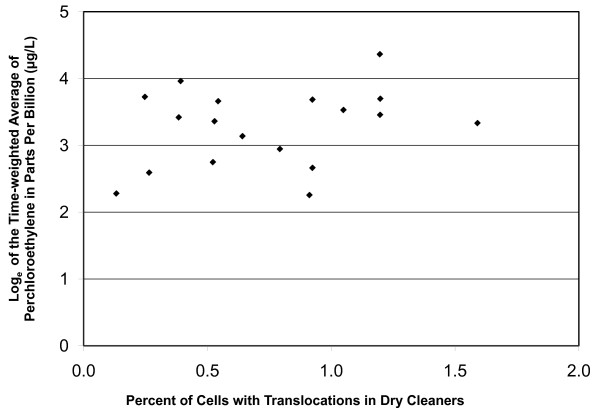
Translocation frequencies by time-weighted average of PCE in the dry cleaners. No significant relationship is evident between translocations and blood PCE levels (R2 = 0.26; p = 0.13).